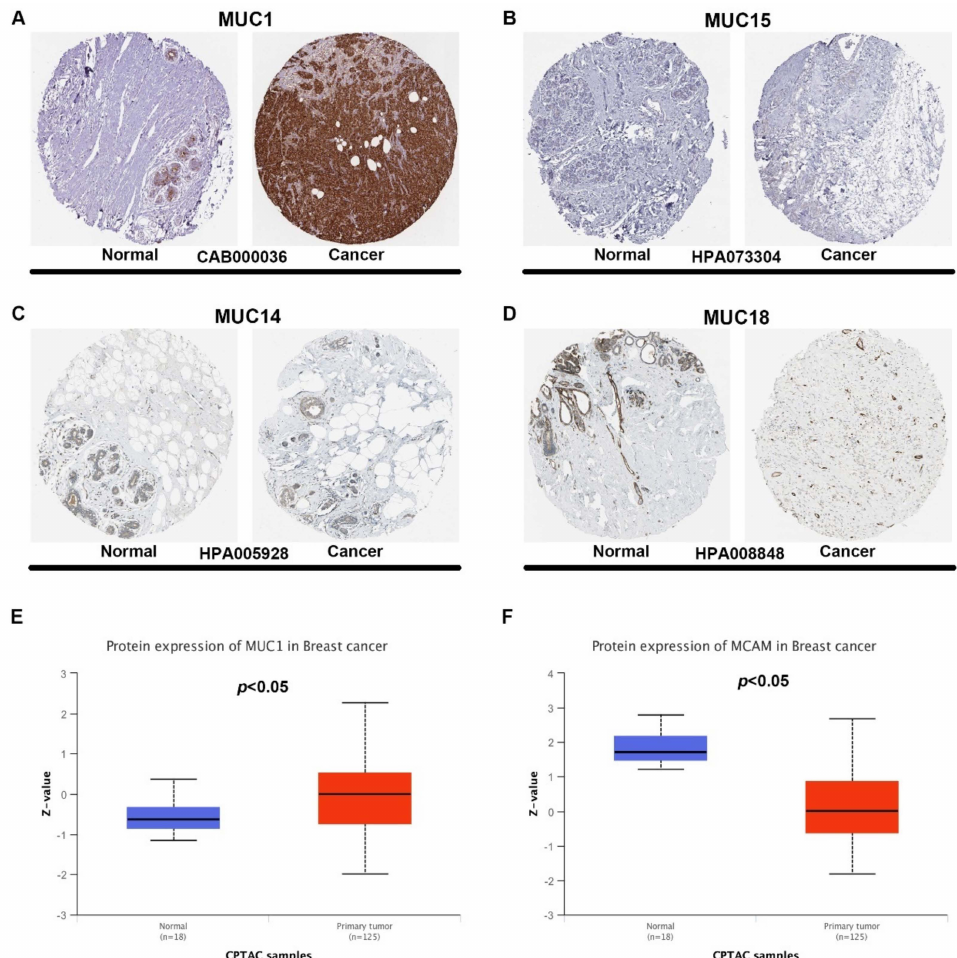
Figure 2. The protein expression of MUCs in breast cancer. The protein expression of MUC1 (( A ), antibody: CAB000036), MUC15 (( B ), antibody: HPA073304), MUC14 (( C ), antibody: HPA005928) and MUC18 (( D ), antibody: HPA008848) in breast cancer and normal control determined by HPA. The protein expression of MUC1 ( E ) and MUC14 ( F ) in breast cancer and normal control determined by CPTAC. “ p < 0.05” was considered as statistically